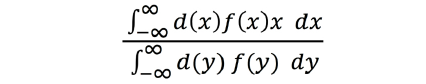
Figure 6. Average observed